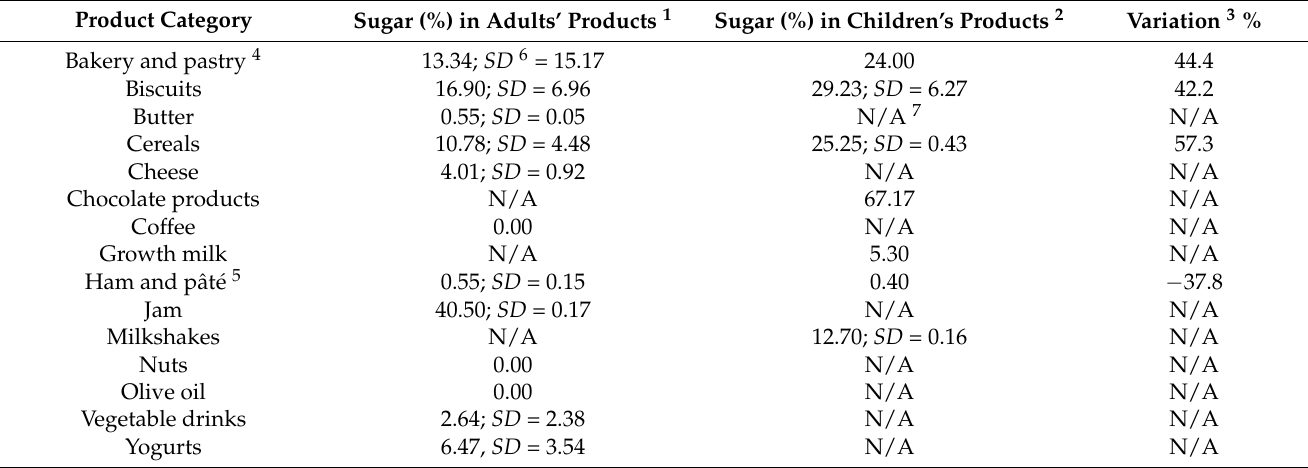
Table 2. Classification of the advertised products by category, average sugar content, and consumer target.